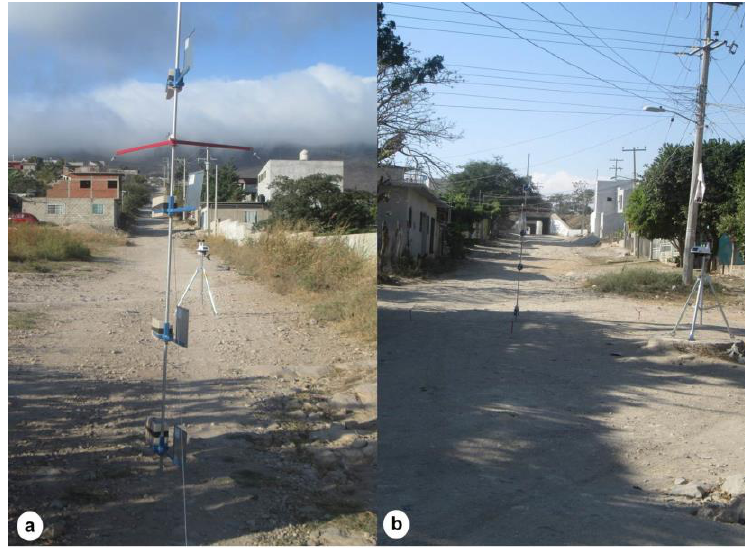
Figure 2. Equipment installation over unpaved roads. ( a ) Lajas Maciel. ( b ) Plan de Ayala.